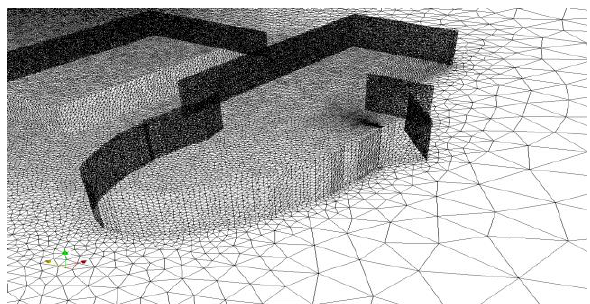
Figure 3. Refined mesh regions around and between building objects